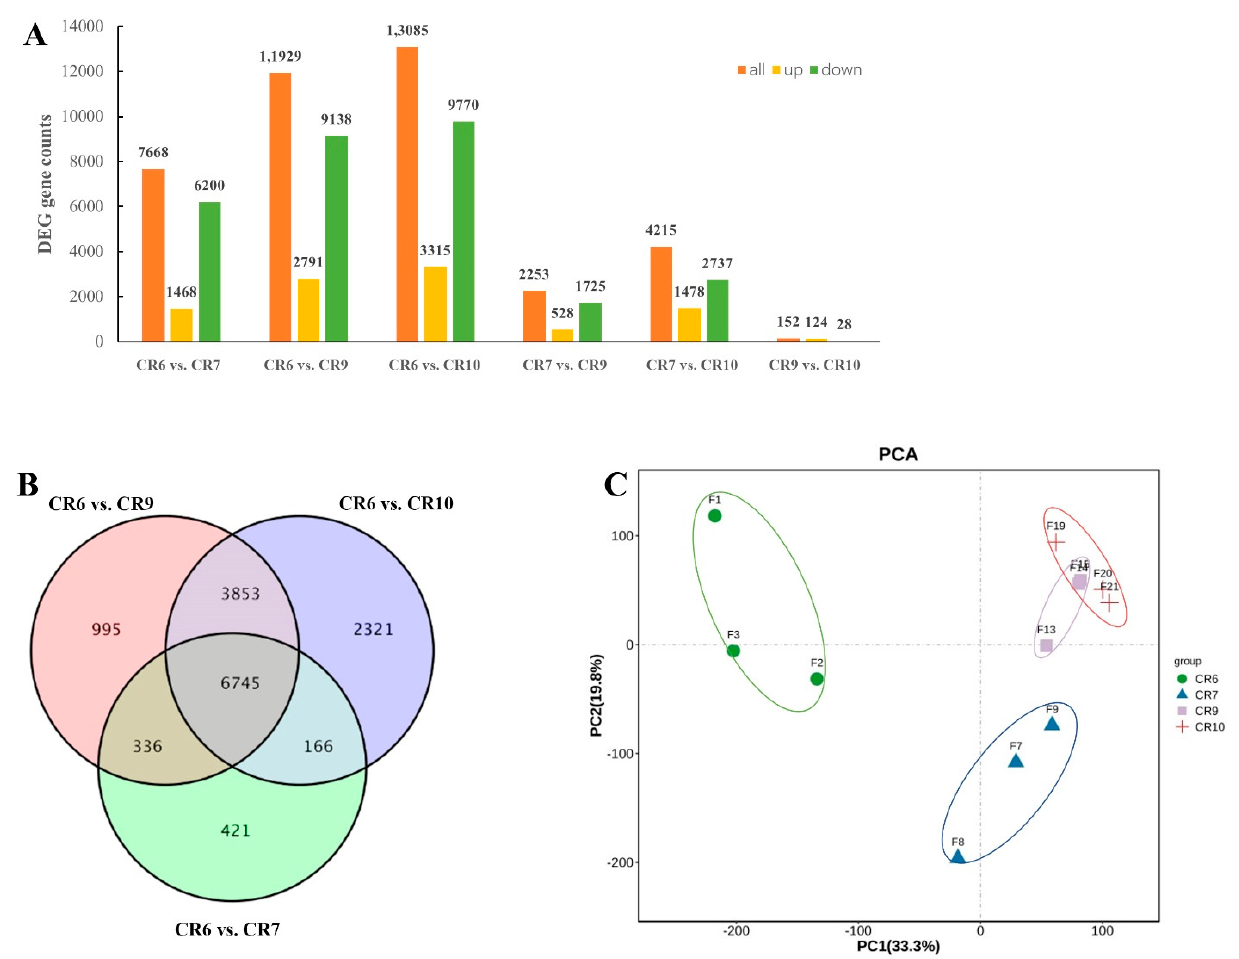
Figure 3. Differentially Expressed Genes (DEGs) of transcriptome sequencing from four fruit devel- opmental stages in C. oleifera. ( A ) Summary of DEGS in all combinations of developmental stage comparisons. ( B ) Venn diagram of CR7, CR9, and CR10 compared with CR6, respectively (false discovery rate (FDR) ≤ 0.01, and |log 2 FC| ≥ 1). ( C ) Principal component analysis (PCA) of CR6 − CR10. The samples from the same development stage were grouped into the same circle.